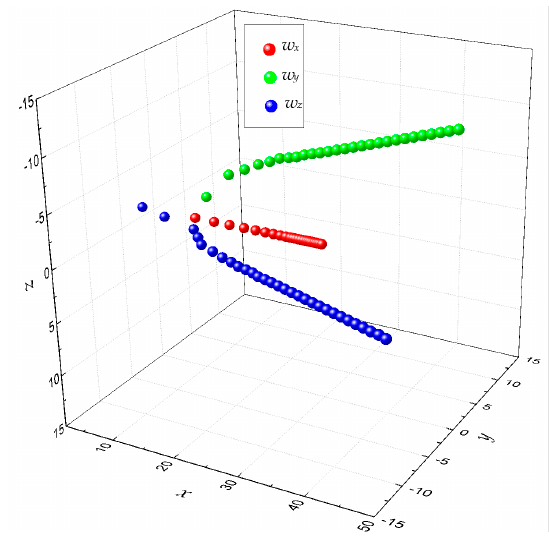
Figure 14. Debris trajectory when the debris penetrated the satellite tank with the angular velocities of w x = 5 rad/ μ s, w y = 5 rad/ μ s, and w z = 5 rad/ μ s.